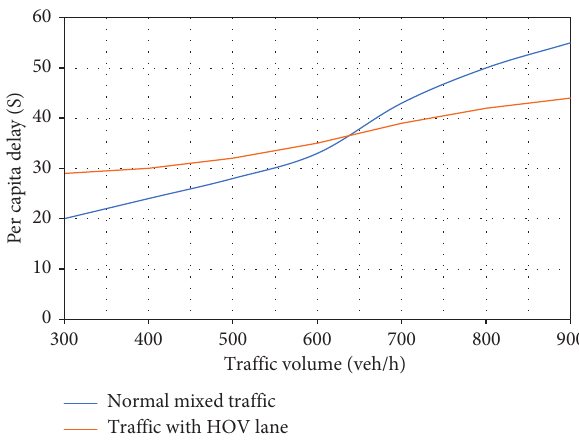
Figure 3: Per capita delay under different traffic conditions at � 160 and n � 3. q b b